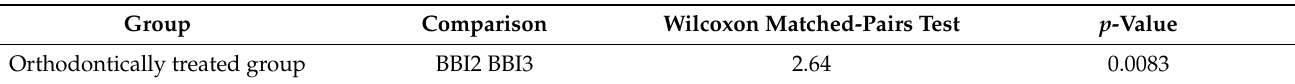
Table 5. Wilcoxon’s pairwise test values for the Bonded Bracket Index in patients treated with a fixed orthodontic ap- pliance (BBI). Group Orthodontically treated